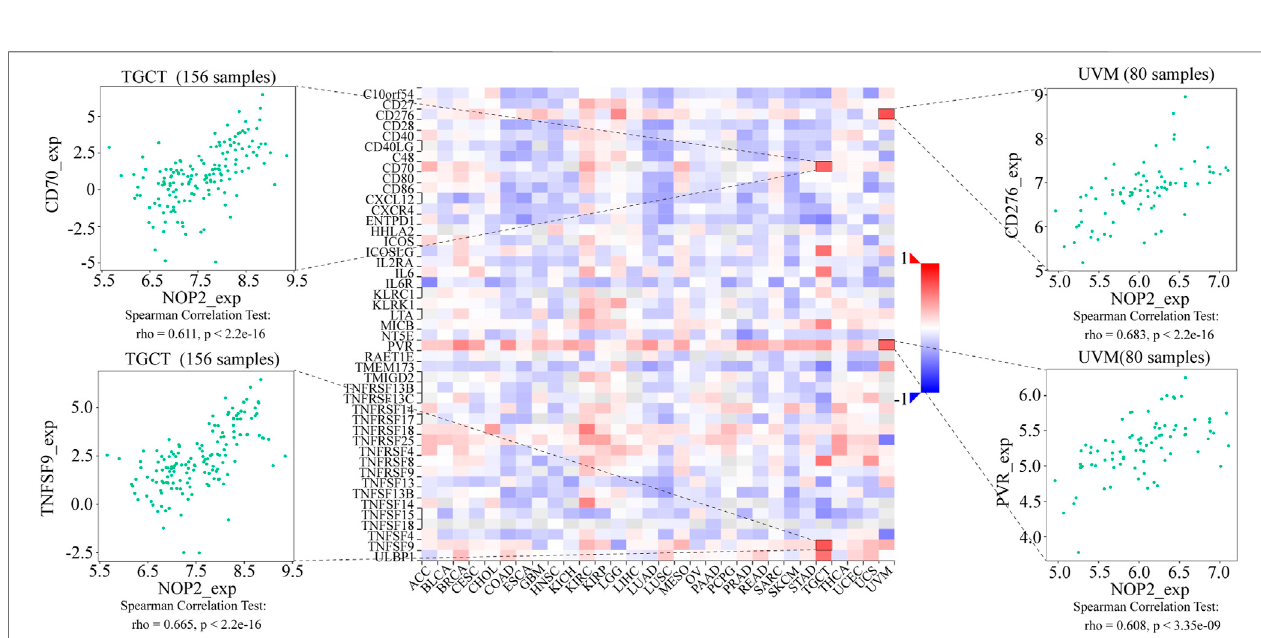
FIGURE7| ExpressioncorrelationbetweenNOP2andimmunestimulators.Redindicatespositivecorrelation,whereasblueindicatesnegativecorrelation.Thetop four strongest associations are displayed via dot plots.